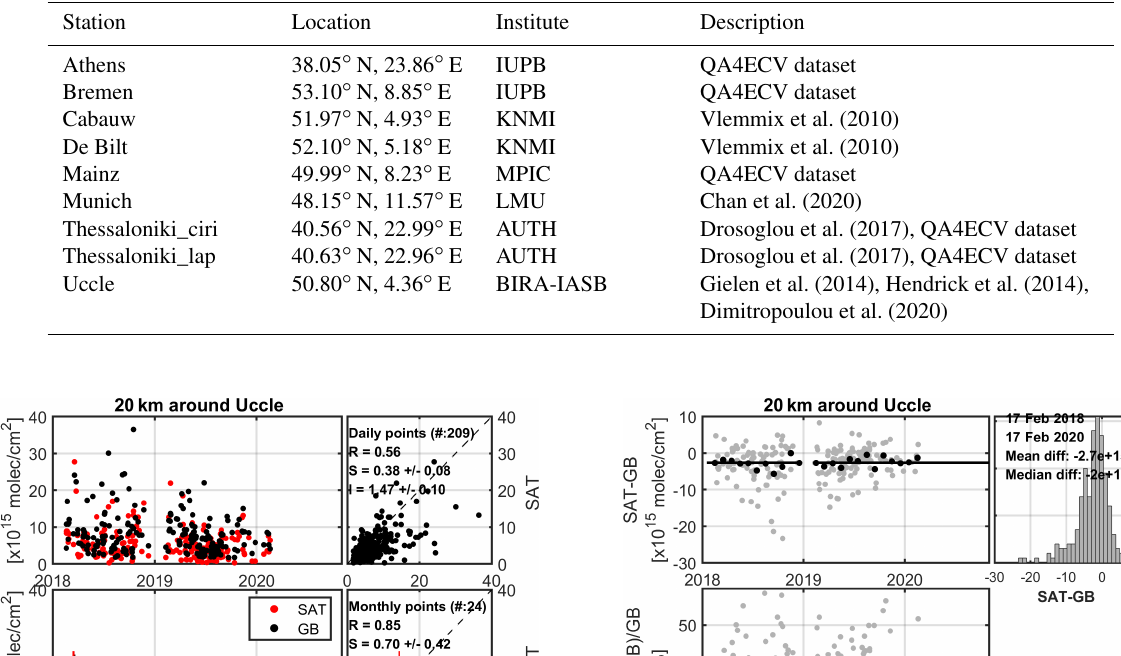
Table 4. An overview of MAX-DOAS stations contributing to the TROPOMI tropospheric NO 2 validation in this study. More details on the QA4ECV datasets can be found at http://www.qa4ecv.eu/ecvs (last access: 1 November 2021).